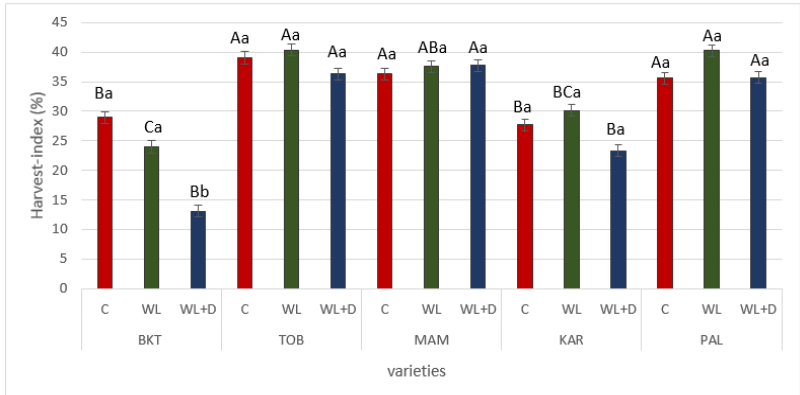
Figure 4. Harvest index values of ‘Bánkúti 1201’ (BKT), “Mv Toborzó” (TOB), ‘Mv Mambó’ (MAM), ‘Mv Karizma’ (KAR) and ‘Mv Pálma’ (PAL) varieties in the different treatments. ‘C’: control treatment; ‘WL’: waterlogging treatment; ‘WL + D’: combined treatment of waterlogging and drought. Capital letters indicate the statistical significance between the varieties at P ≤ 0.05 level; lowercase letters indicate the statistical significance between the treatments at P ≤ 0.05. Error bars represent honestly significant difference (HSD) 5% values (n = 3).